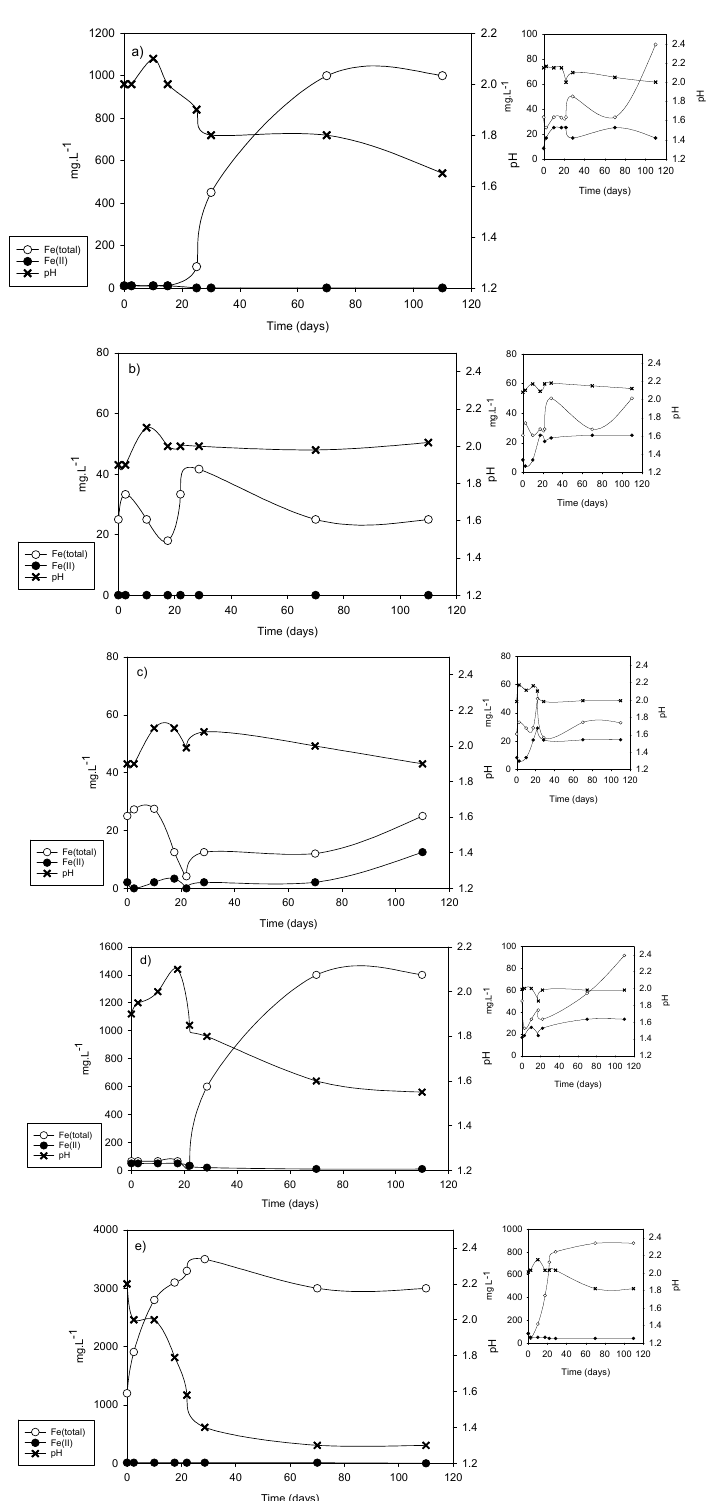
Figure 5. Biooxidation of samples from the horizontal profiles in DC2 dam (pulp density: 2% w/v). ( a ) DC2-1; ( b ) DC2-2; ( c ) DC2-3; ( d ) DC2-4; ( e ) DC2-5. Evolution of total soluble iron and ferrous iron concentration, and pH in inoculated (left ) and uninoculated ( right ) systems.